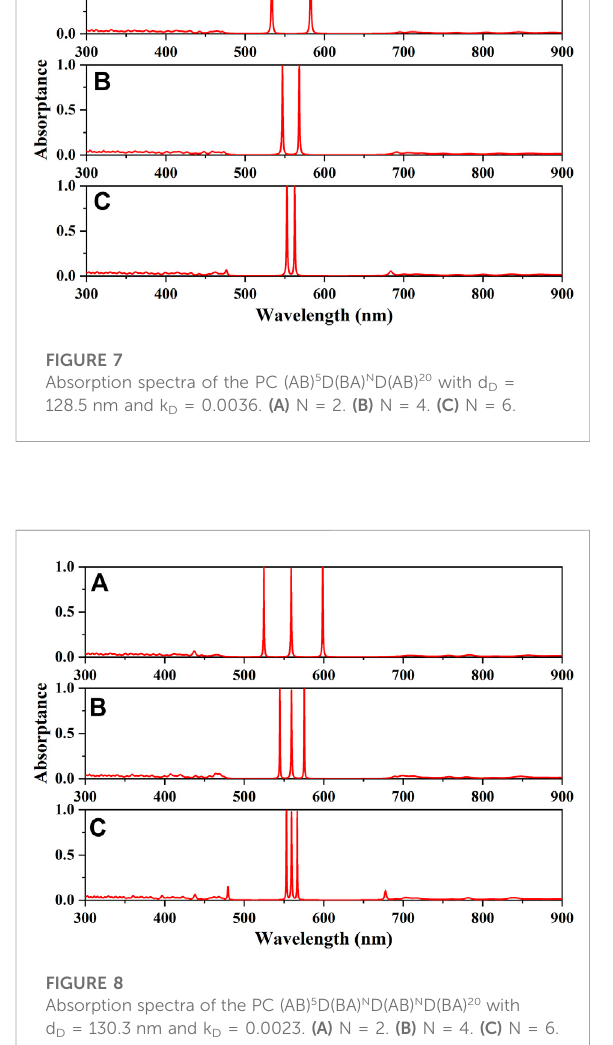
whole visible range for (AB) 5 D(BA) N D(AB) N D(BA) 20 with